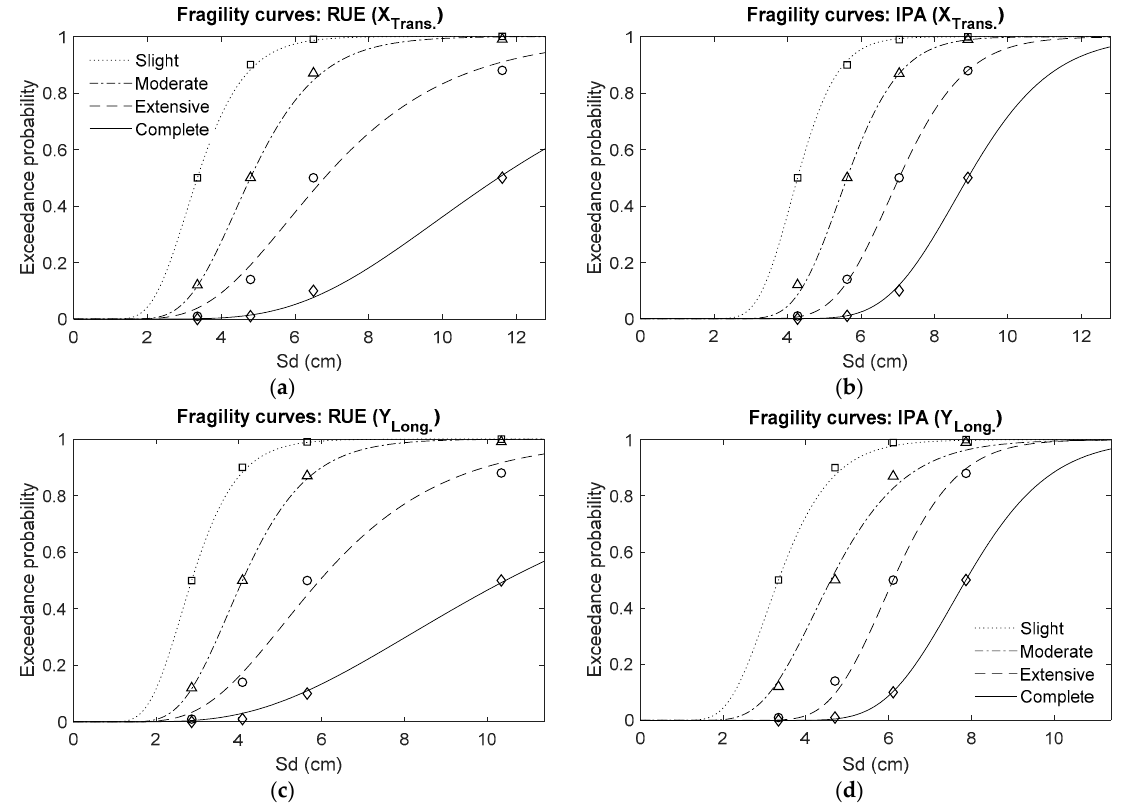
Figure 12. Fragility curves: ( a ) X-direction, Risk-UE thresholds, ( b ) X-direction, Park and Ang index thresholds; ( c ) Y- direction, Risk-UE thresholds, ( d ) Y-direction, Park and Ang index thresholds.